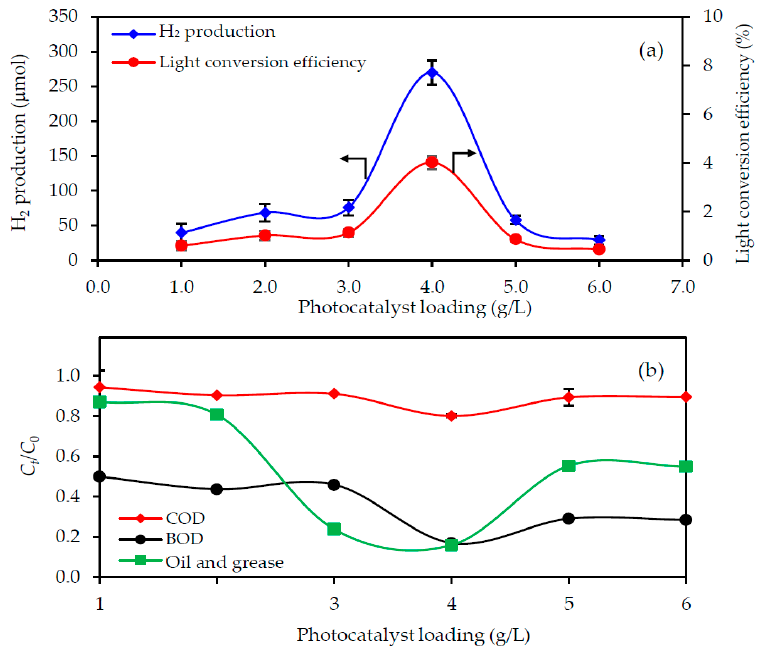
Figure 4. Effect of the photocatalyst loading on the level of ( a ) H 2 production with light conversion efficiency and ( b ) pollutant removal from the 3.3-fold diluted acid-pretreated biodiesel wastewater at an initial pH of 2.3 with a UV light at intensity of 4.79 mW/cm 2 for 4 h.